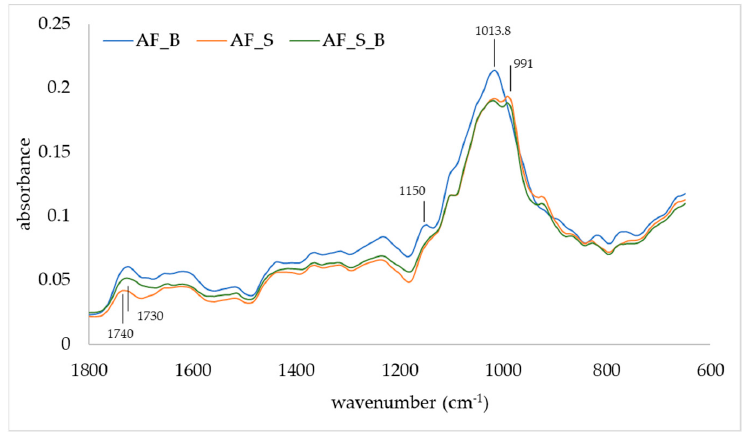
Figure 3. IR spectra of apple fiber/blackberry (AF_B), apple fiber/sucrose (AF_S), and apple fiber/sucrose/blackberry (AF_S_B) microparticles.